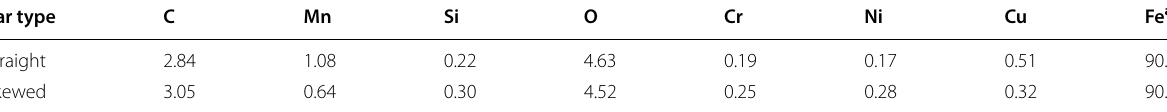
Table 2 Chemical composition of the different bar type steels (% of